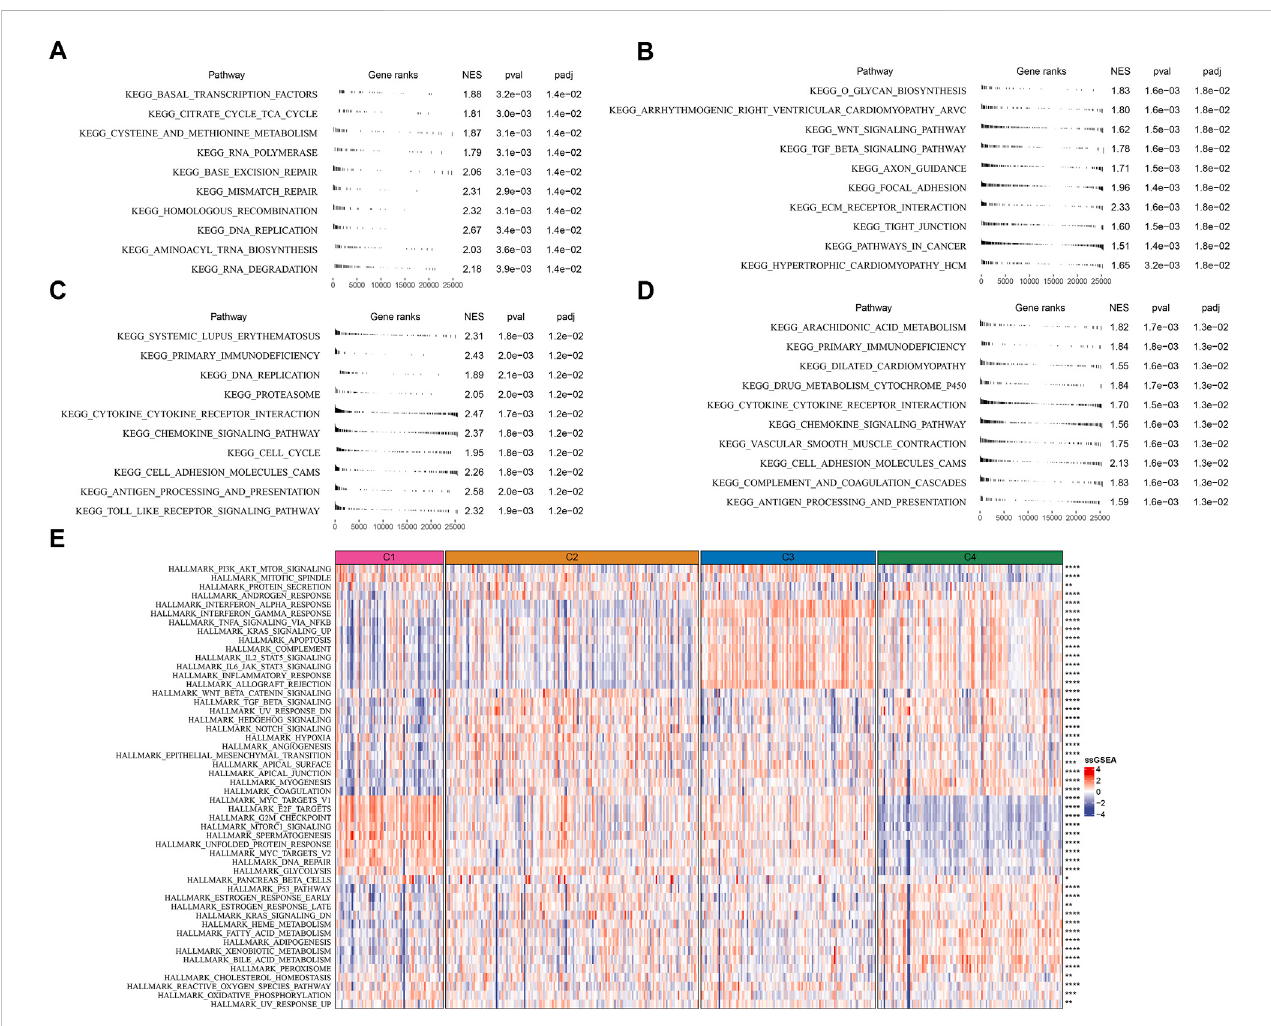
FIGURE 4 AnalysisofKEGGandhallmarkpathwaysinTCGAdataset (A – D) GSEArevealedthetop10enrichedKEGGpathwaysofC1 (A) ,C2 (B) ,C3 (C) ,andC4 (D,E) The heatmap showed the enrichment of hallmark pathways. Comparison of the enrichment score among four subtypes was performed and the signi fi cance was shown in the right. * p < 0.05, ** p < 0.01, *** p < 0.001, **** p <